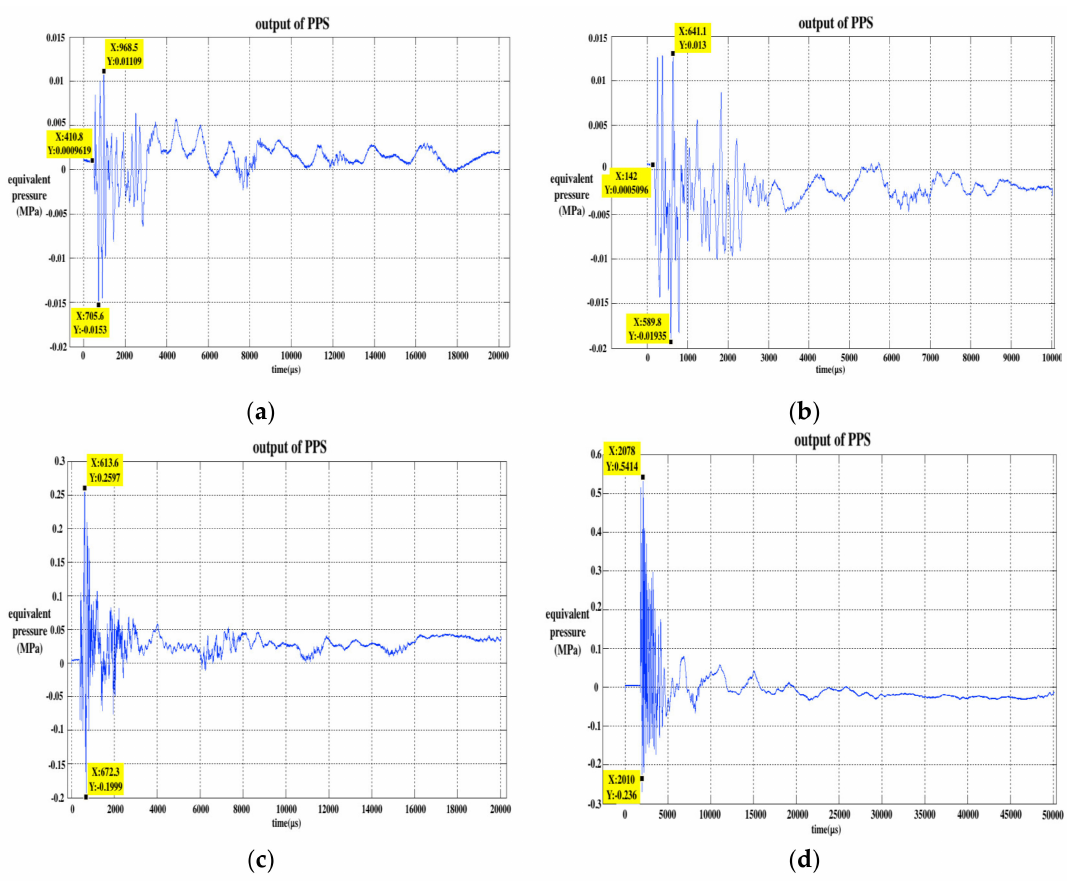
Figure 8. Output of the PPS for the stress wave isolation experiment at 120 degrees: ( a ) 16 mm nylon isolation pedestal; ( b ) 30 mm nylon isolation pedestal; ( c ) 16 mm Plexiglass isolation pedestal; ( d ) 30 mm Plexiglass isolation